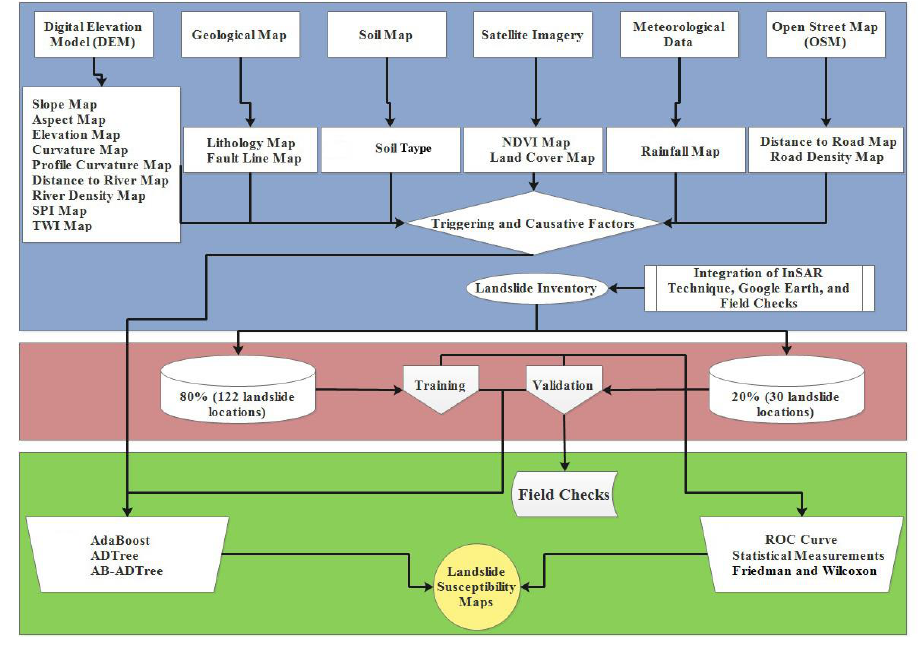
Figure 9. Research methodology for landslide susceptibility mapping in the Cameron Highlands,